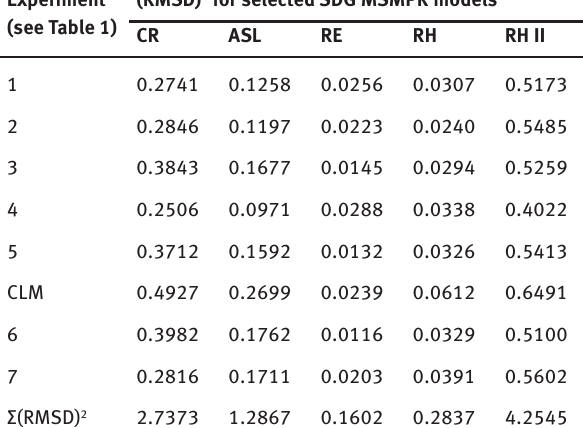
Table 3: (RMSD) 2 for each model/experimental case, as well as Σ(RMSD) 2 for each SDG MSMPR model (for all experimental data sets).